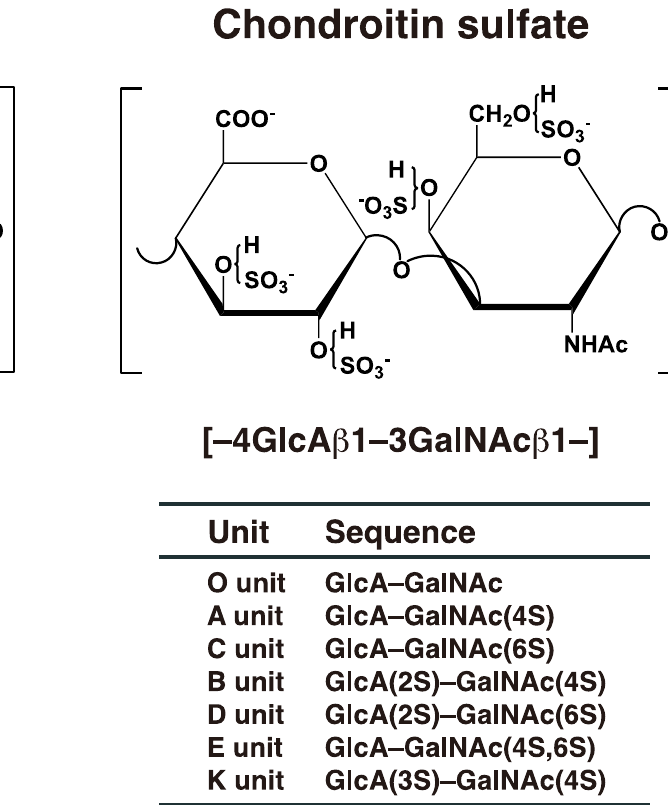
Figure 1. Typical repeating disaccharide units in CS and DS, and their potential sulfation sites. The CS backbone consists of GlcA and GalNAc, whereas DS is a stereoisomer of CS that includes IdoA instead of GlcA. These sugar moieties may be esterified by sulfate at various positions indicated by “SO 3– ”. The disaccharide units of CS and DS chains are classified as shown. The abbreviation “i” in DS units stands for IdoA, and 2S, 3S, 4S, and 6S stand for 2- O -, 3- O -, 4- O -, and 6- O -sulfate groups, respectively. The representative disaccharide compositions of CS/DS from various tissues and animal species are described in reference [11].